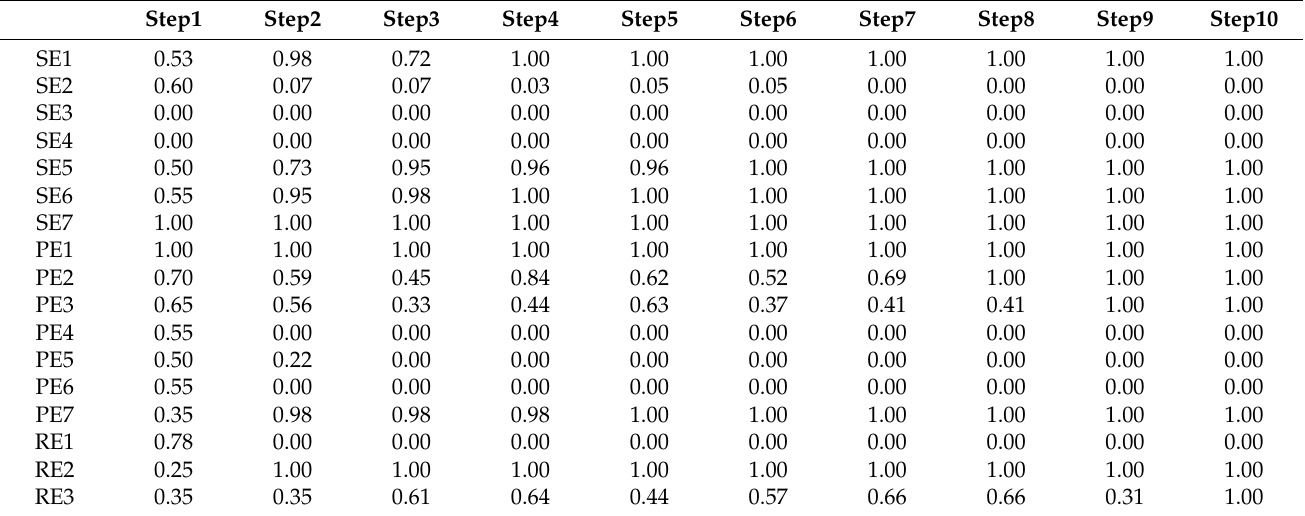
Table 12. Simulation probability for non-occurrence of SE3 and SE7, and occurrence of SE4 and PE1.